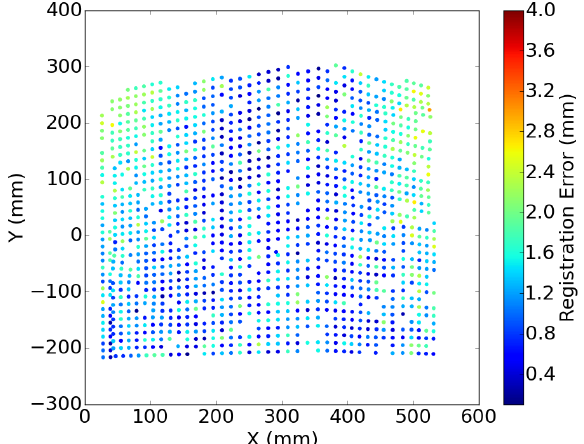
Figure 5 Registration error between LIDAR and Stereo point